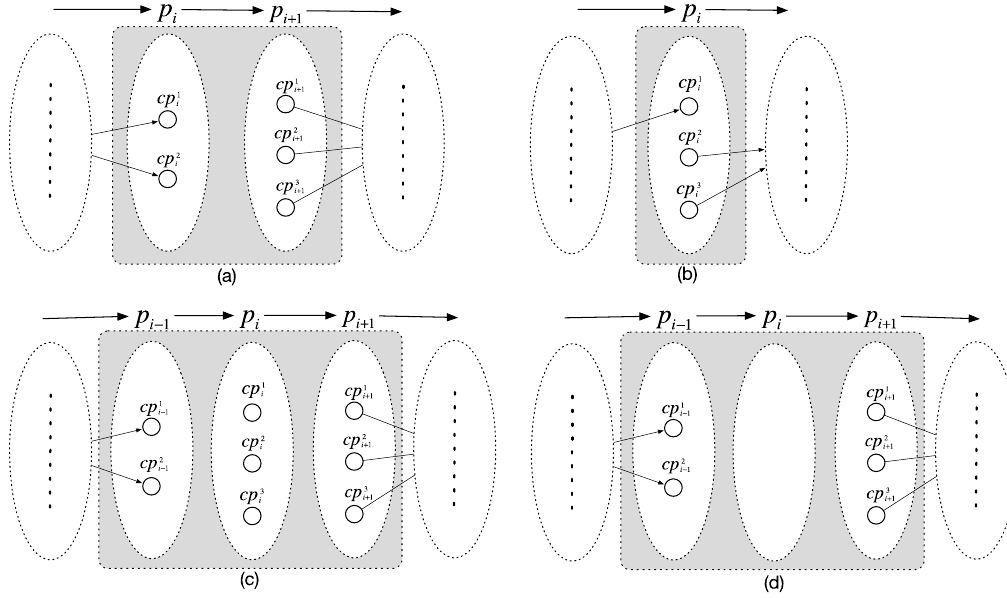
Figure 5. Four types of fractures in G ′: ( a ) the fracture between two sequential sampling points; ( b ) the fracture on one sampling point; ( c ) a fracture among multiple sequential sampling points; and ( d ) a fracture among multiple sequential sampling points, in which there is sampling point without any candidate position.